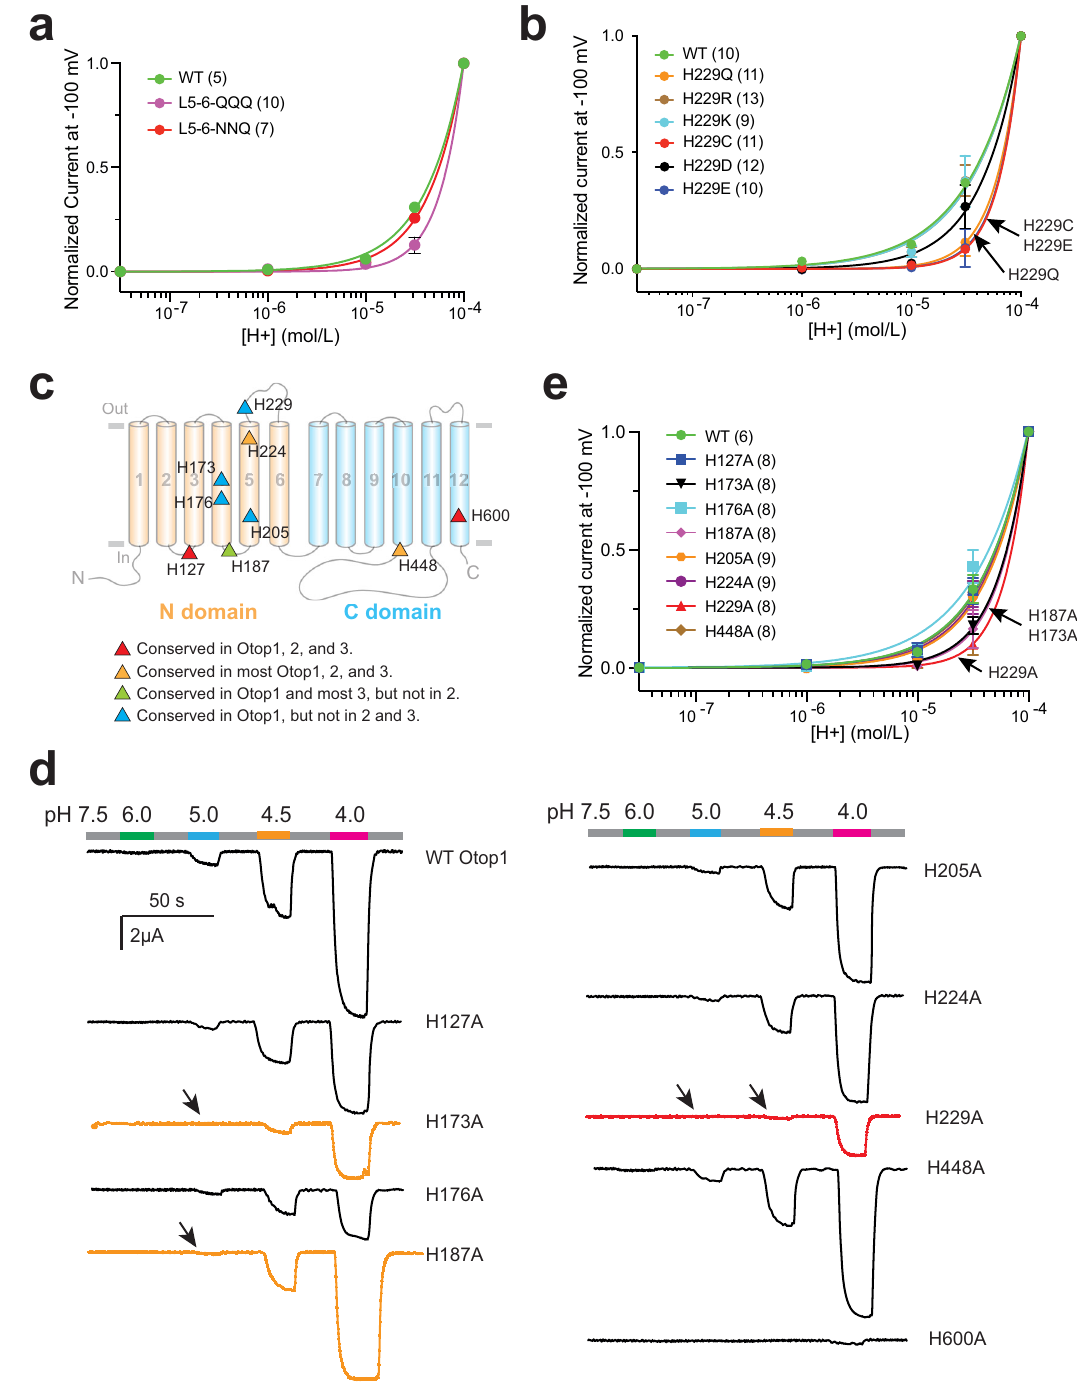
Fig. 3 H229 in L5 – 6 is a key residue for the proton sensing of the human Otop1 channel. a , b , e Proton dose – response curves showing the acid sensitivity comparison between the WT and the indicated mutant channels. The currents of every oocyte at other pHs were normalized to the current at pH 4 at − 100 mV. The data were fi tted by nonlinear regression with variable slope. We were unable to calculate an accurate EC 50 of these channels. Since it is not possible to separate the proton sensing and proton conductance in this case, theoretically, we are not able to obtain the saturated proton concentration. c Predicted positions of indicated histidine residues in the topology structure of human Otop1. The residues are colored based on their conservation in Otop proteins as indicated at the bottom. d Gap-free recording shows the currents of indicated histidine mutants at different pHs. The oocytes were held at − 60 mV. The currents of H229A, H173A, and H187A, the three mutants that have altered proton sensitivity, are in red or orange. Arrows indicated the missing responses to protons at the indicated